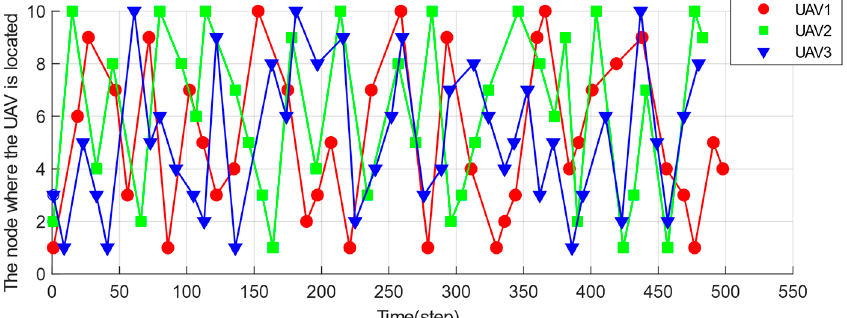
Figure 4. The persistent monitoring path obtained by the OMACO algorithm.